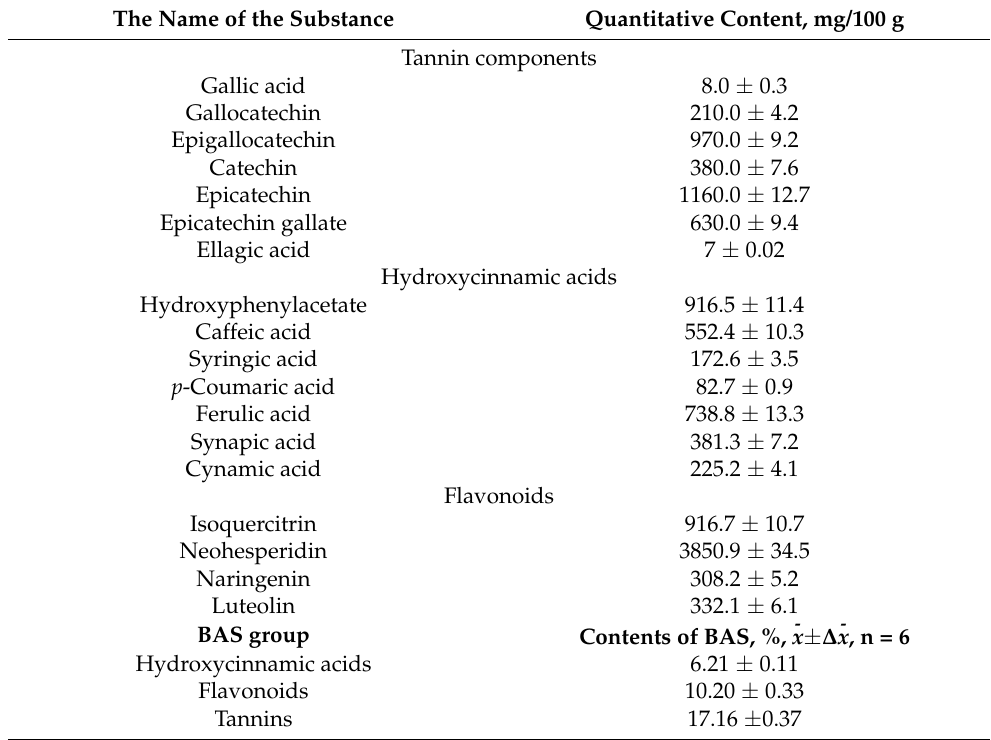
Table 3. Qualitative composition and quantitative content of phenolic compounds in the herb extract of A. eupatoria